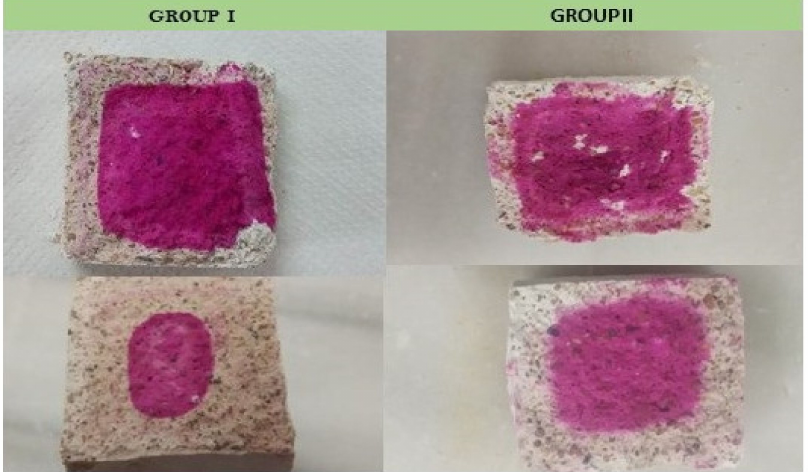
Figure 10. View of the fracture of representative specimens (40 × 40 × 40 mm 3 ) of Group In and IIn cured for 28 days (upper), cured for 90 days (bottom).